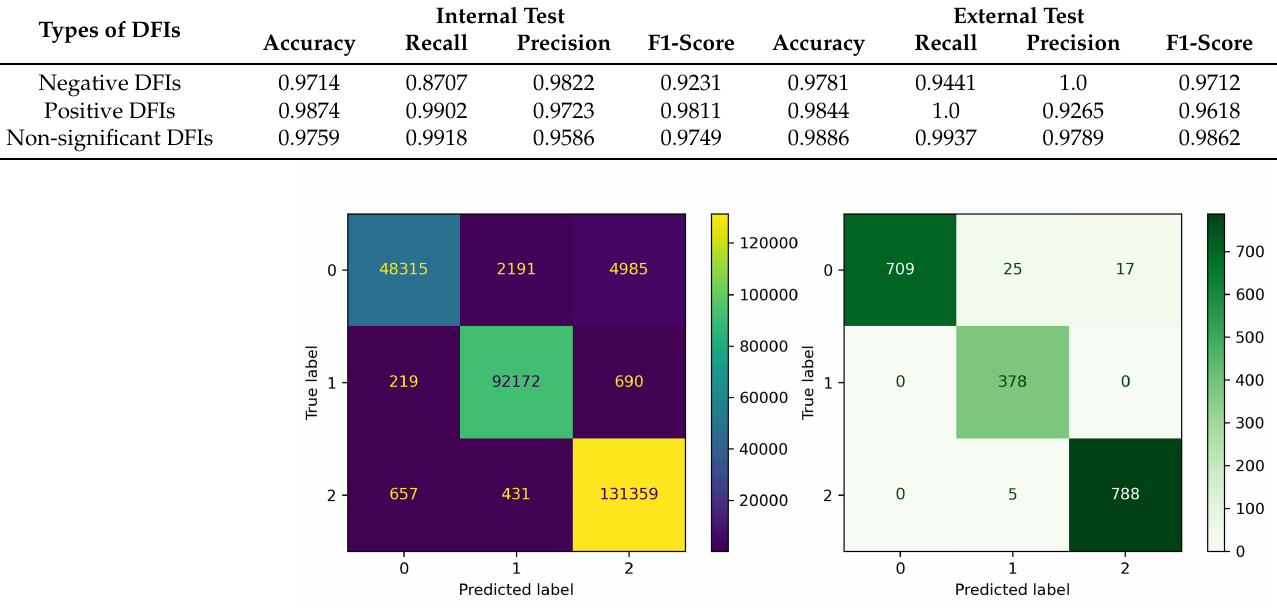
Figure 2. Confusion matrix of our optimal XGBoost model on the testing and the external test sets. On the testing set ( left plot): The model most accurately detected positive and non-significant DFIs (recall 0.99 in both classes) while only recognizing 87% of negative DFIs. Likewise, on the external test set ( right plot), the model recognized all positive DFIs and 99% of non-significant DFIs. Negative DFIs were recognized as acceptable, with 94% of those discriminated